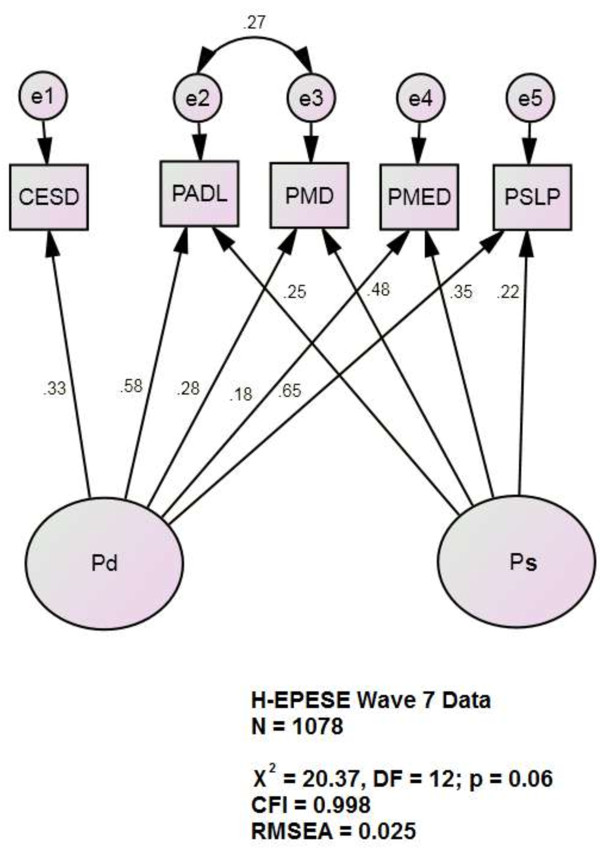
Latent variables Pd and Ps*. CES-D = Centers for Epidemiological Studies-Depression scale; CFI = Comparative Fit Index; DF = degrees of freedom; H-EPESE = Hispanic Established Population for Epidemiological Studies in the Elderly; PADL = self reported pain-related functional limitations; Pd = depression-related pain report; PMD = self reported pain-related doctor visits; PMED = self reported pain-related medication use; Ps = somatic-related pain report; RMSEA = Root Mean Statistical Error Assessment; PSLP = self-reported pain-related sleep disturbance. *All observed variables are adjusted for age, gender, the number of prescribed pain medications, Mini-mental State Exam scores, body mass index, living alone and adequacy of monthly financial support (covariates not shown for clarity).